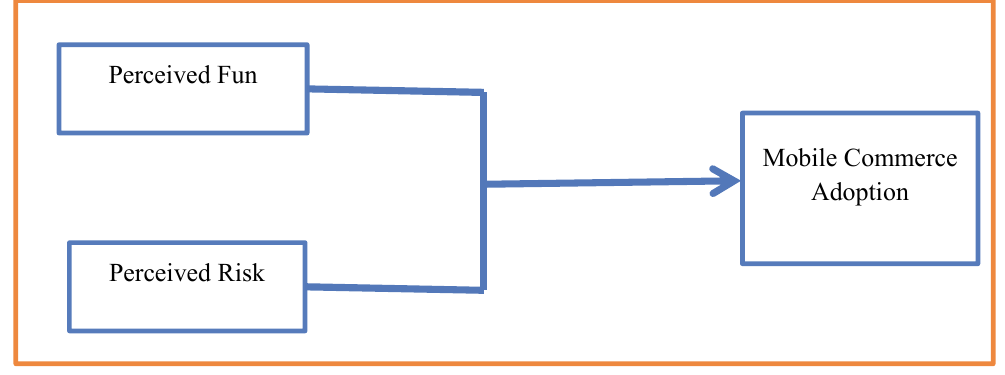
Fig. 1. Conceptual